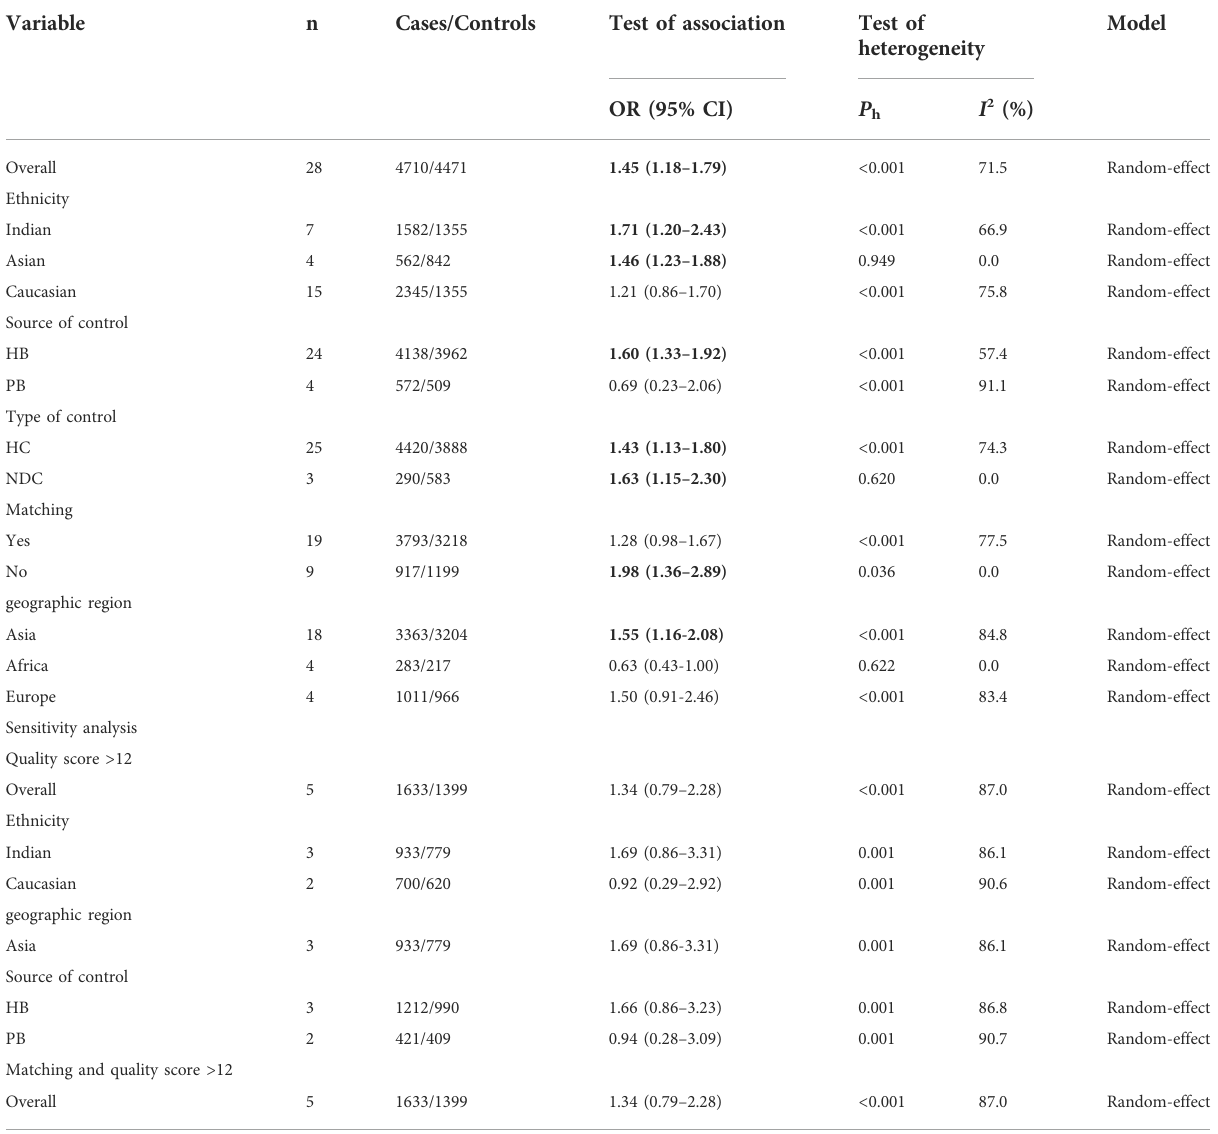
TABLE 2 Meta-analysis of the association of GSTT1 polymorphism with risk of